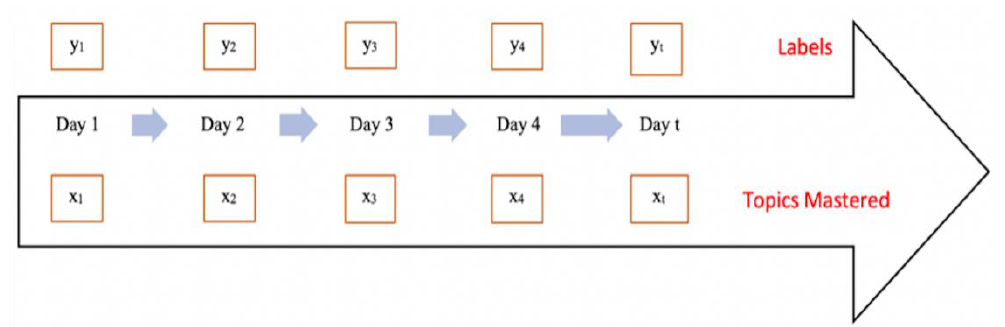
Figure 3. The Data Preprocessing Method: Sequence Classification.